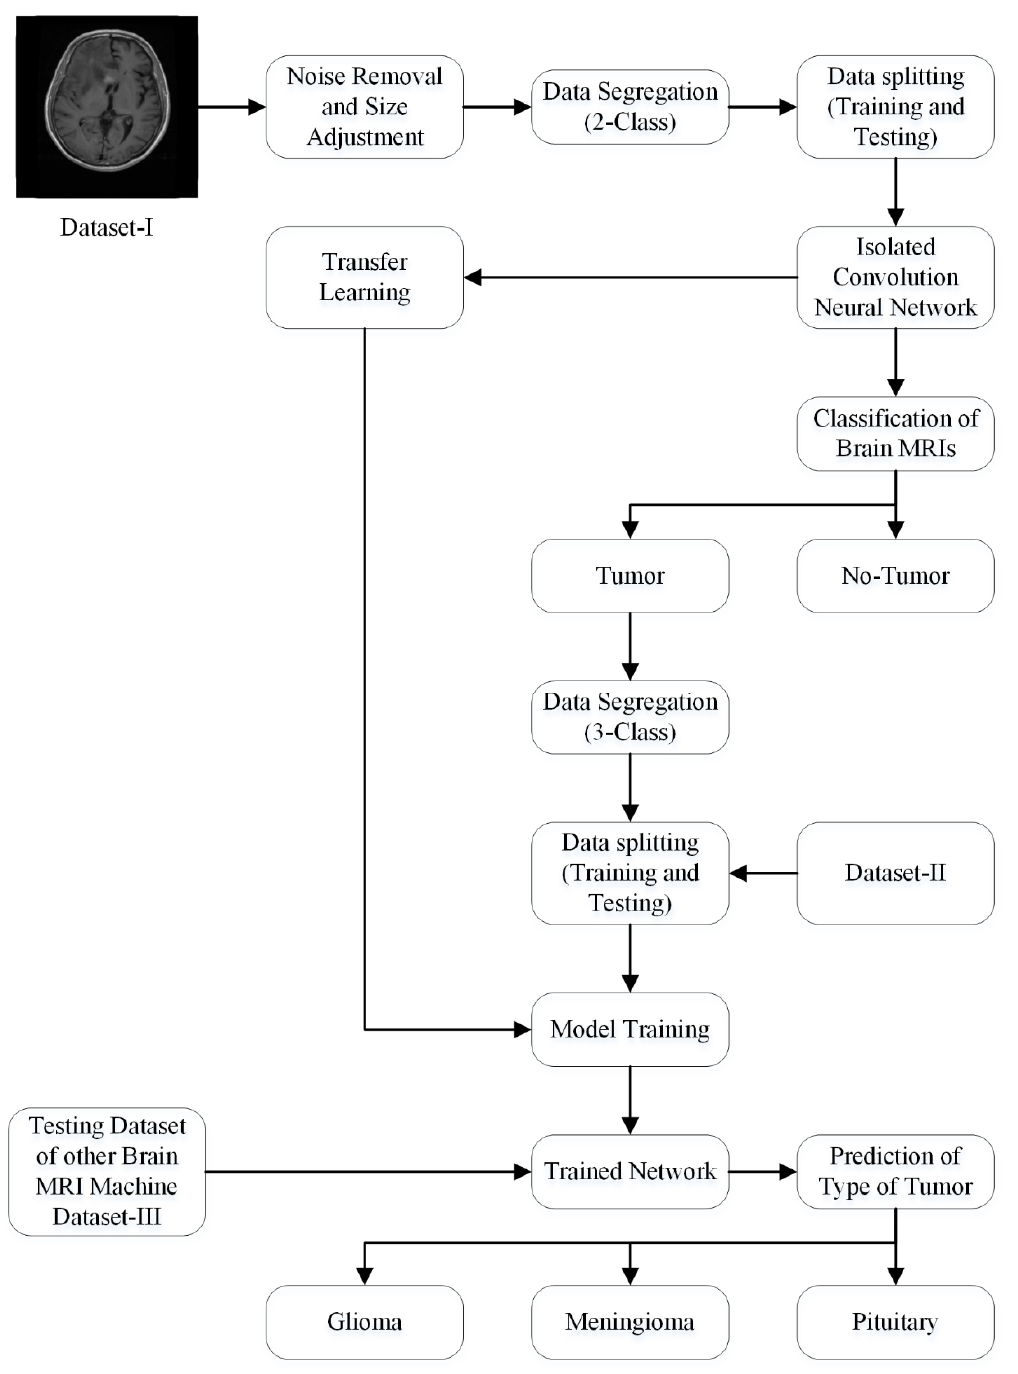
Figure 4. The framework of the proposed